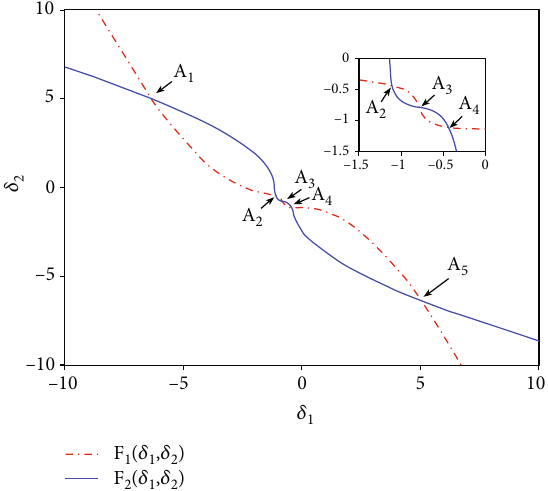
. ext Figure 7: Function curves of (4) and (5) as well as the intersection points when k = 0 : 1 . The red curve corresponds to function (4), and the blue one is for function (5). A intersection points.